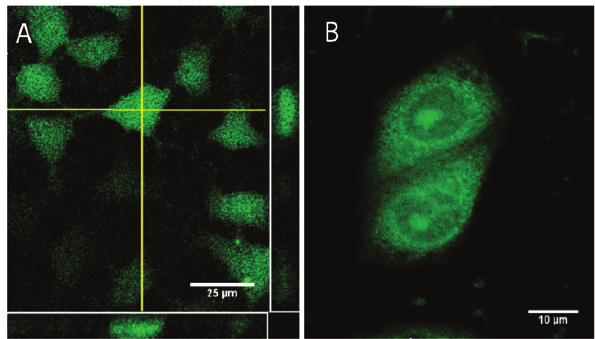
Figure 7. (A) Confocal imaging of spiroligomer 3 (2 m M 3, incubated for 24 hours and then washed with PBS) in live Huh7 cells. Yellow lines represent two orthogonal sections of a z-series showing the distribution of green fluorescence in the cells. (B) Optically sectioned HepG2 cells exposed to spiroligomer 1 (0.5 m M 1 , incubated for 15 hours and then washed with PBS) by confocal microscopy. Spiroligomer 1 is localized in both cytoplasmic and nuclear compart- ments.